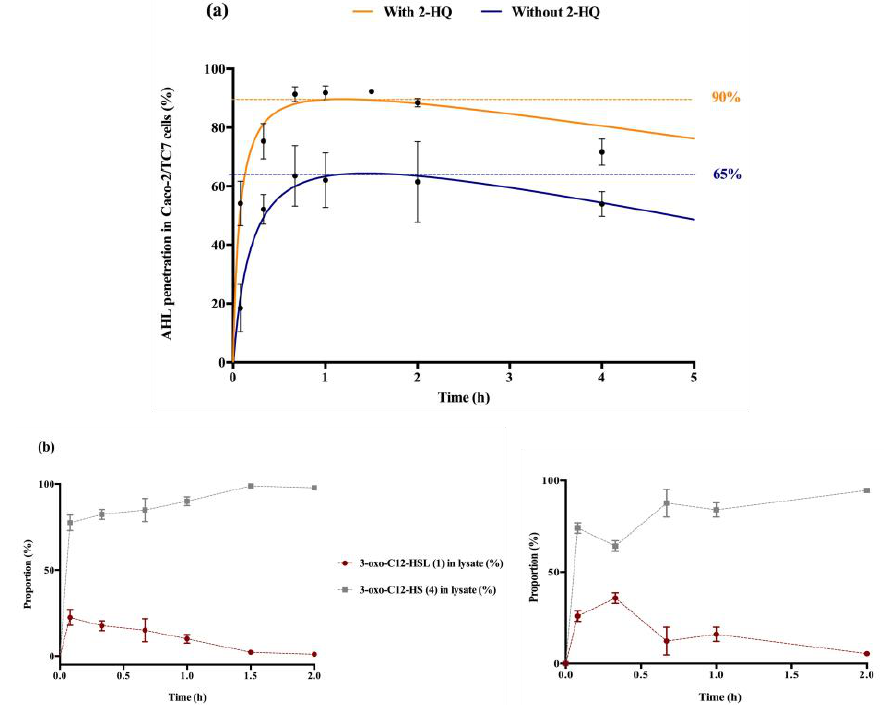
Figure 3. Cellular traffic of 3-oxo-C12-HSL: ( a ) Influence of 2-HQ on AHL penetration in Caco-2/TC7 cells over time, expressed as % of initial AHL concentration. ( b ) Time evolution of 3-oxo-C12-HSL and 3-oxo-C12-HS % in Caco-2/TC7 cell lysates in the presence (left) or absence (right) of 100 µM 2-HQ (truncated time profile). Points are the mean value of replicates ( n = 3) ± SEM.